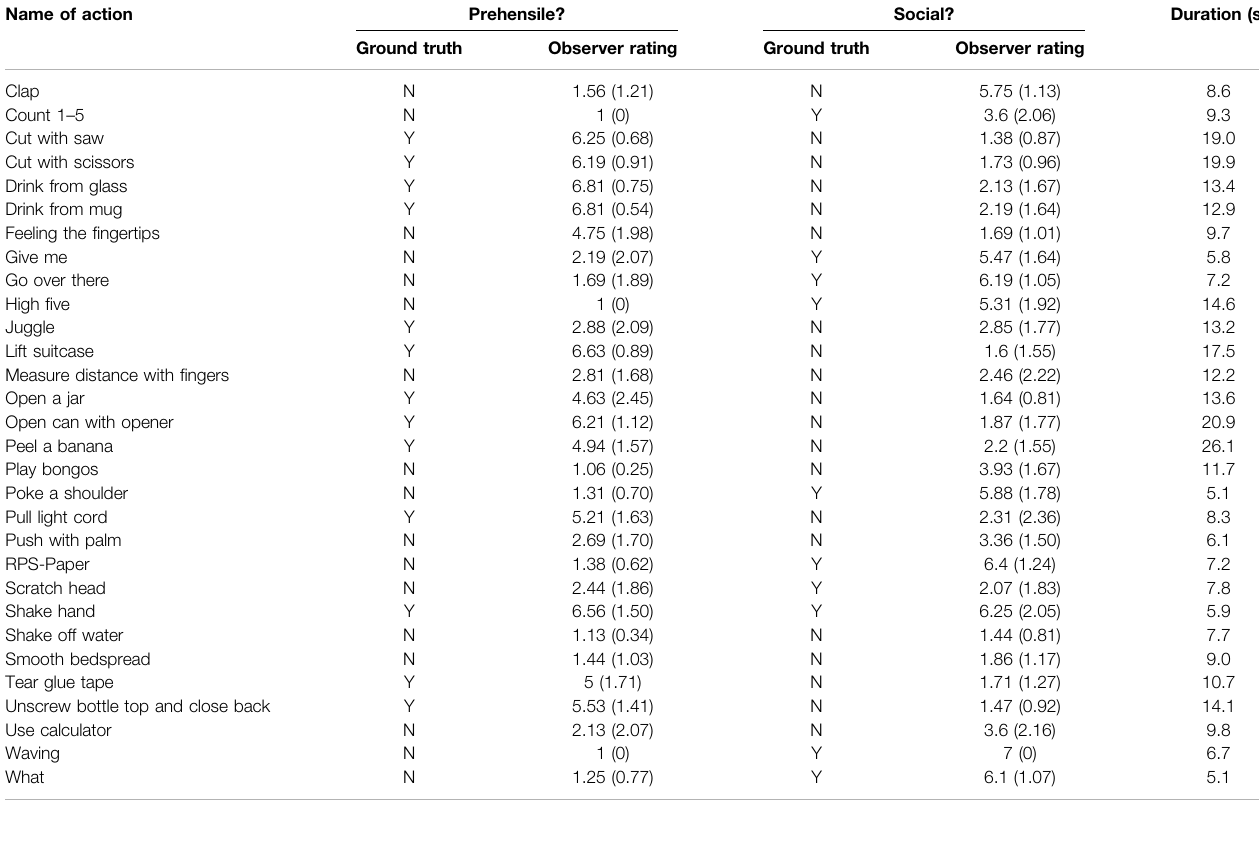
TABLE 2 | Gestures in the experiment. Means and standard deviations (in brackets) of observer ratings for each point-light gesture. N (cid:1) no and Y (cid:1) yes, grouped according the labels Prehensile? and Social?